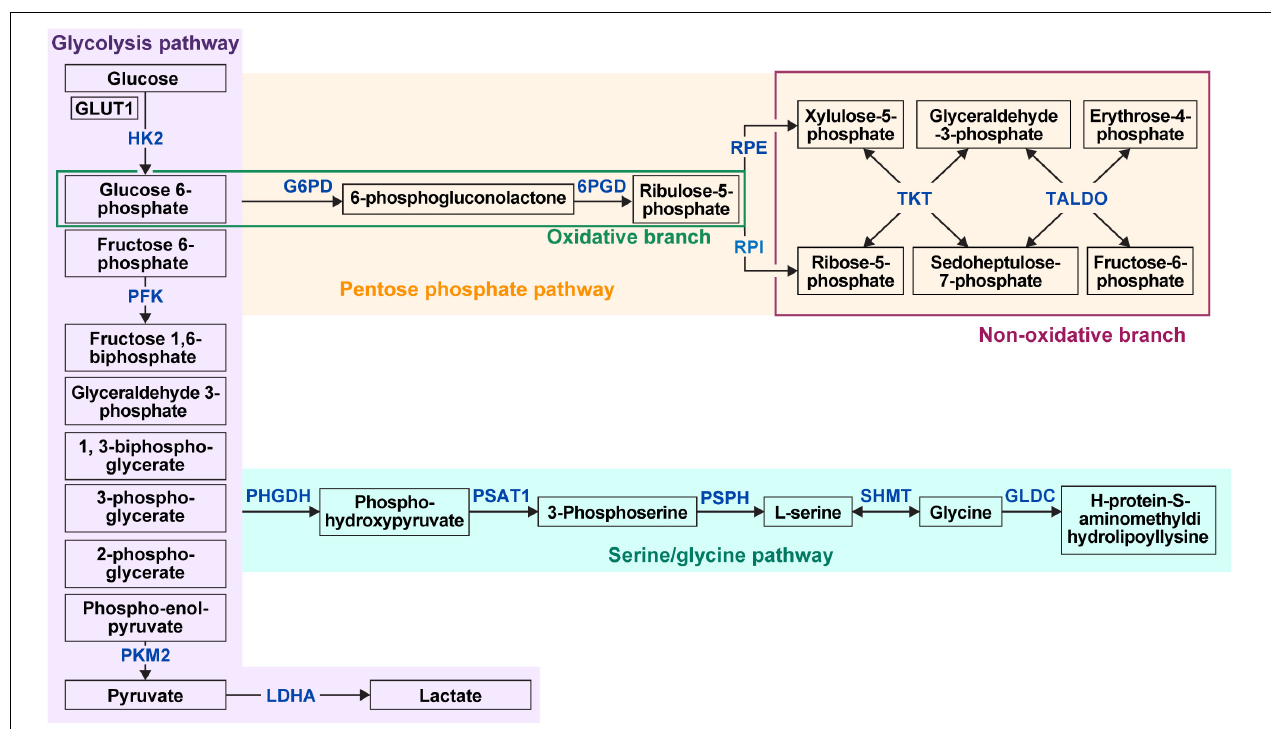
FIGURE 1 | Overview of glucose metabolism in cancer cells. Glucose metabolism in tumor cells consists of three main types: glycolysis, the pentose phosphate pathway (PPP), and the serine/glycine pathway. First, in glycolysis, glucose influx occurs in the cell by glucose transporter GLUT1. Using HK2, PFK, and PKM2, glucose becomes pyruvate and is eventually converted to lactate by LDHA. PPP comprises an oxidative branch and a non-oxidative branch, where glucose 6-phosphate is converted to 6-phosphogluconolactone and then ribulose-5-phosphate by 6PGD and G6PD. The non-oxidative branch produces xylulose-5-phosphate by RPE and ribose-5-phosphate by RPI, and then produces fructose 6-phosphate, glyceraldehyde 3-phosphate, sedoheptulose- 7-phosphate, and erythrose-4-phosphate by TKT and TALDO through complex interchangeable reactions. The serine pathway starts with 3-phosphoglycerate, which is converted to phosphohydroxypyruvate by PHGDH, which is converted to 3-phosphoserine by PSAT1, and 3-phosphoserine is converted to serine by PSPH. In addition, glycine is converted by GLDC to H-protein- S -aminomethyldihydrolipoyllysine in glycine metabolism, which is linked to serine metabolism by SHMT in the form of reversible conversion. HK2, hexokinase II; PFK, phosphofructokinase; PKM2, pyruvate kinase isozymes M2; LDHA, lactate dehydrogenase A; G6PD, glucose 6-phosphate dehydrogenase; 6PGD, 6-phosphogluconate dehydrogenase; RPE, ribulose-5-phosphate epimerase; RPI, ribose 5-phosphate isomerase; TKT, transketolase; TALDO, transaldolase; PHGDH, phosphoglycerate dehydrogenase; PSAT1, phosphohydroxythreonine aminotransferase; PSPH, phosphoserine phosphatase; SHMT, serine hydroxymethyltransferase; GLDC, glycine